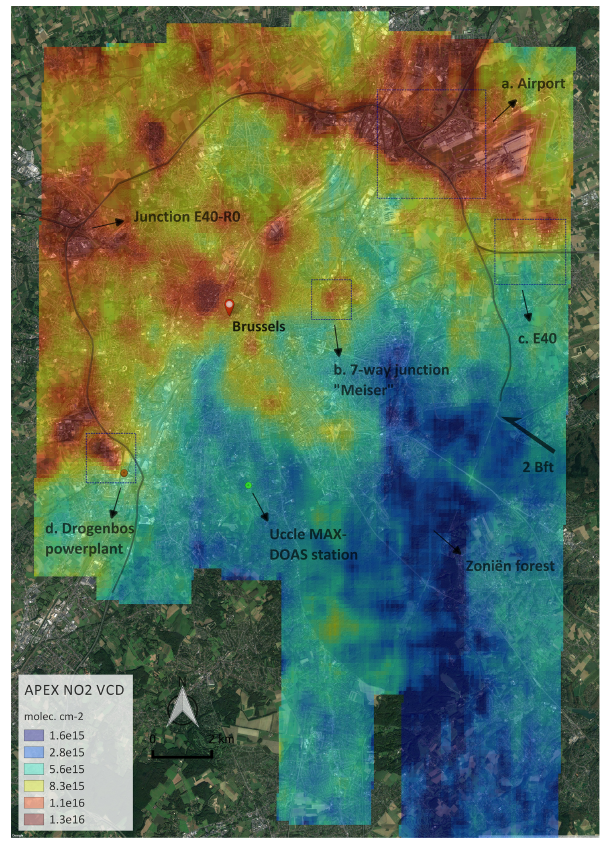
Figure 17. Retrieved NO 2 VCD field for Brussels (30 June 2015) (Google, TerraMetrics). Blue squares indicate four NO 2 VCD hotspots, highlighted in Fig. 18. The green dot is the location of the Uccle MAX-DOAS station.